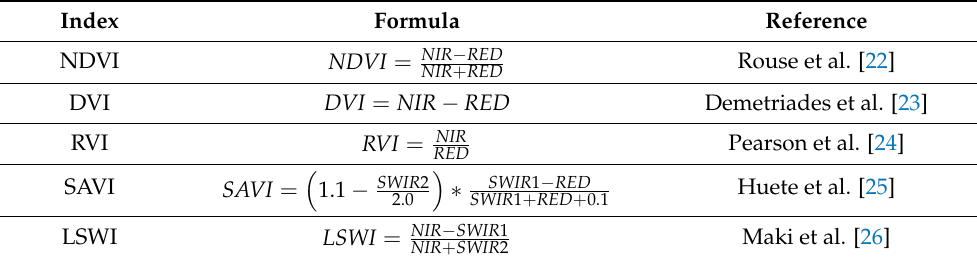
Table 2. Vegetation indices for extracting coniferous forest.